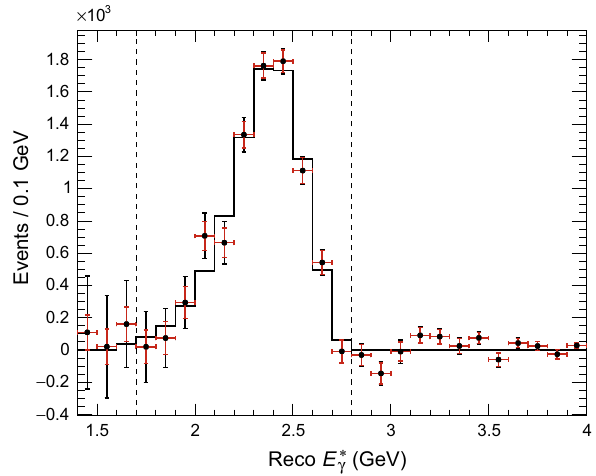
Fig. 1 Background-subtracted ¯ B → X s + d γ photon energy